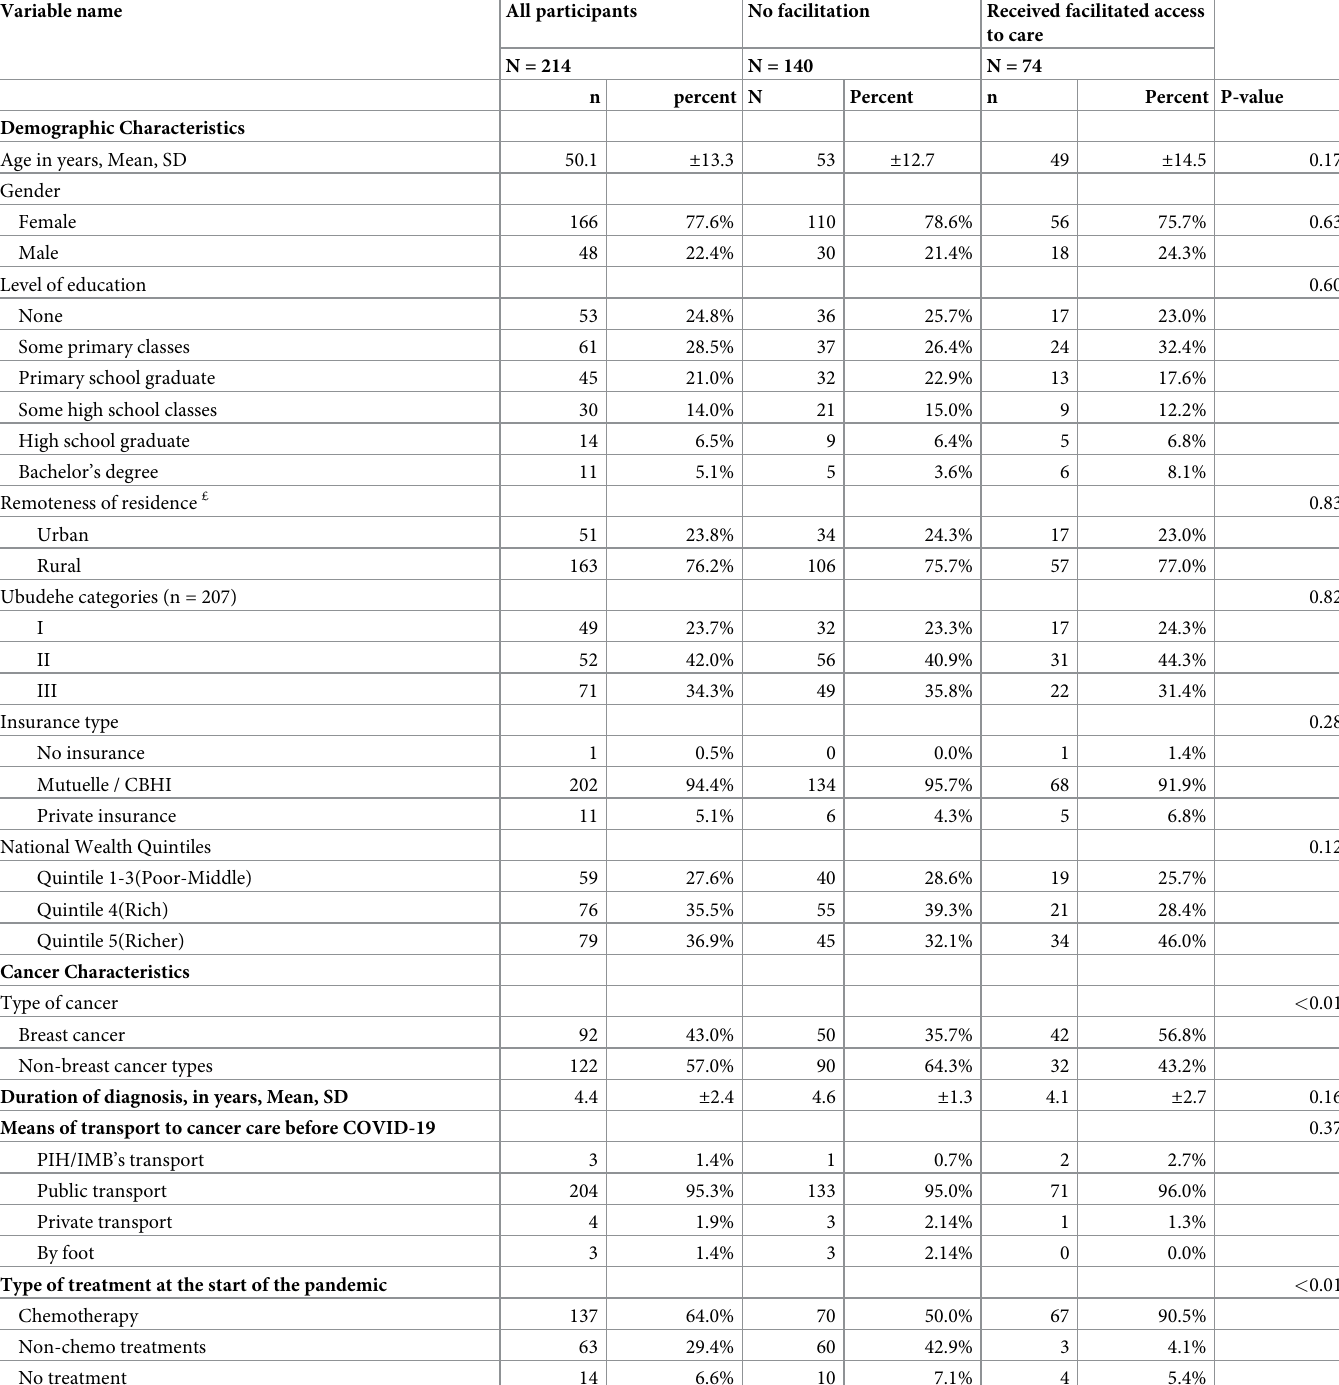
Table 1. Baseline characteristics of study participants stratified by receipt of facilitated access to care (N =